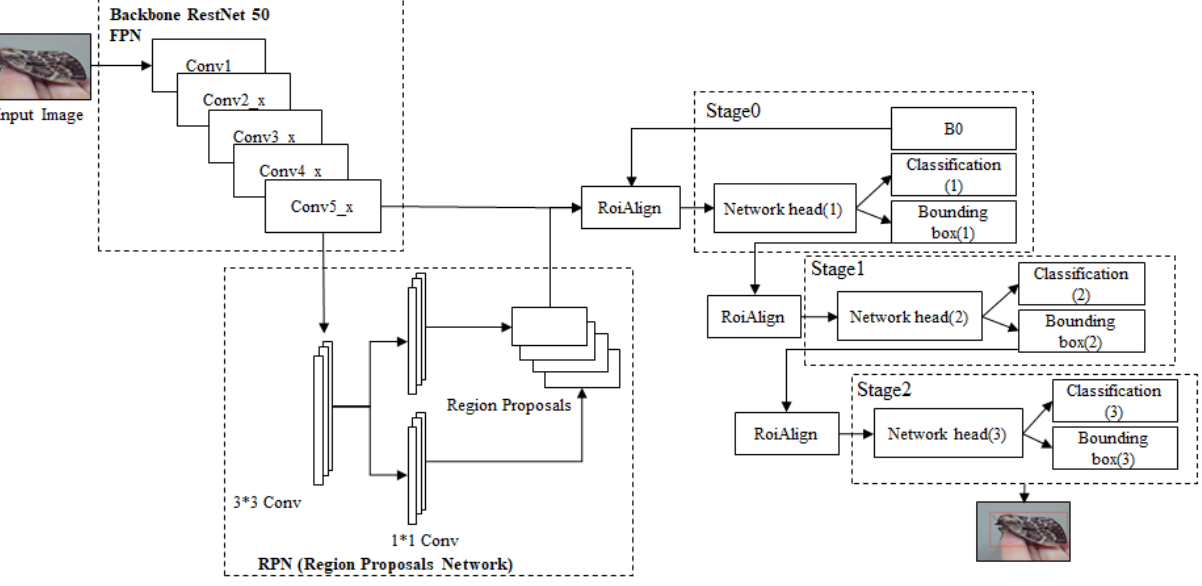
Figure 5. Design of pine pest Detection using the Cascade R-CNN